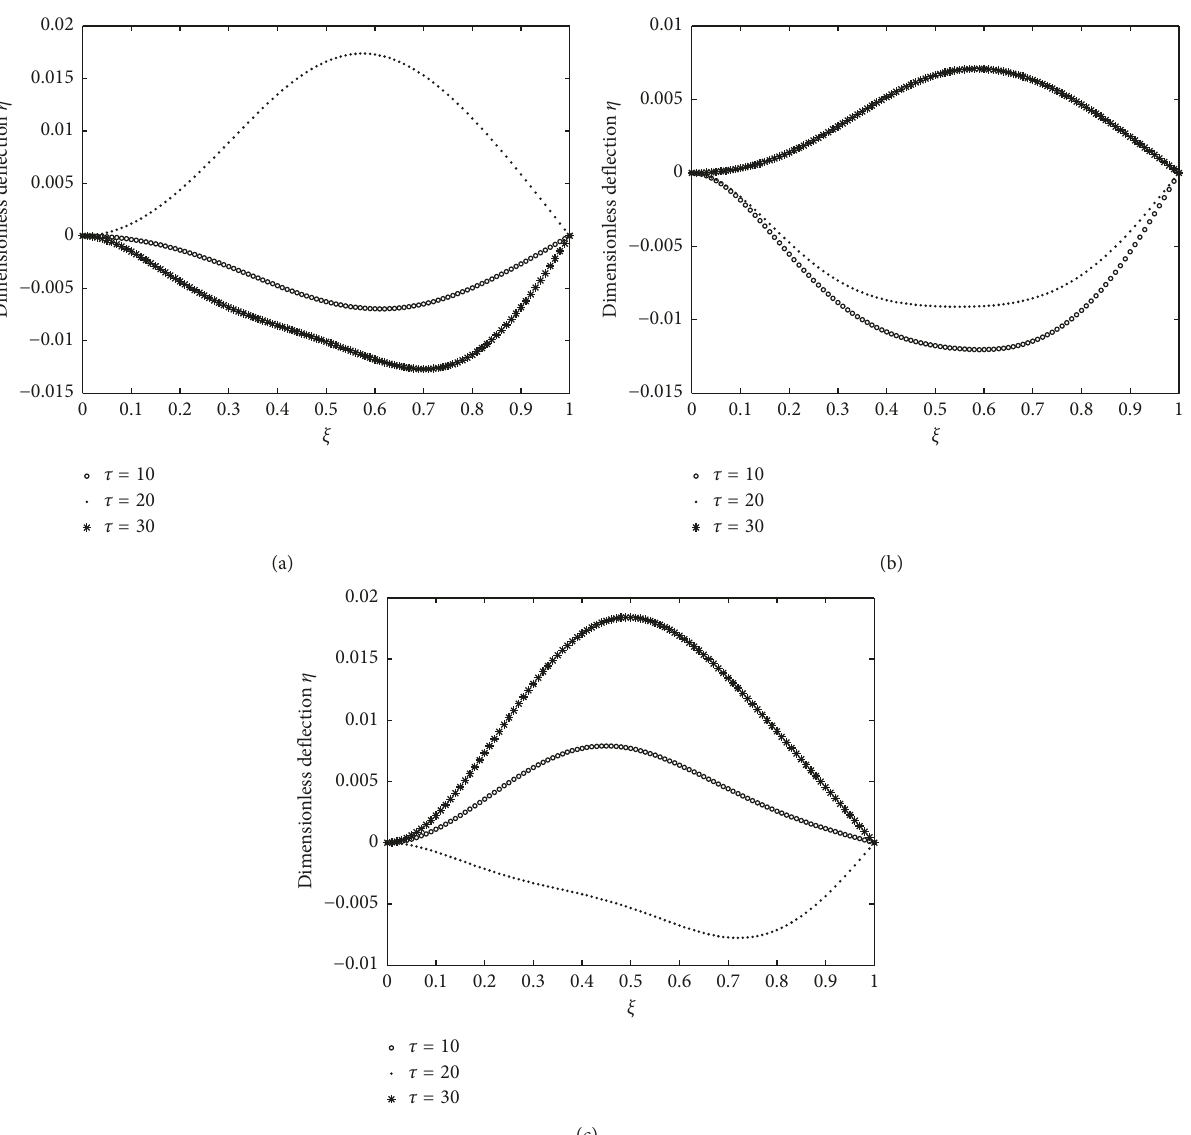
Figure 12: The deflection responses of the clamped-pinned pipe under different fluid velocities: (a) u � 0; (b) u � 1; (c) u �